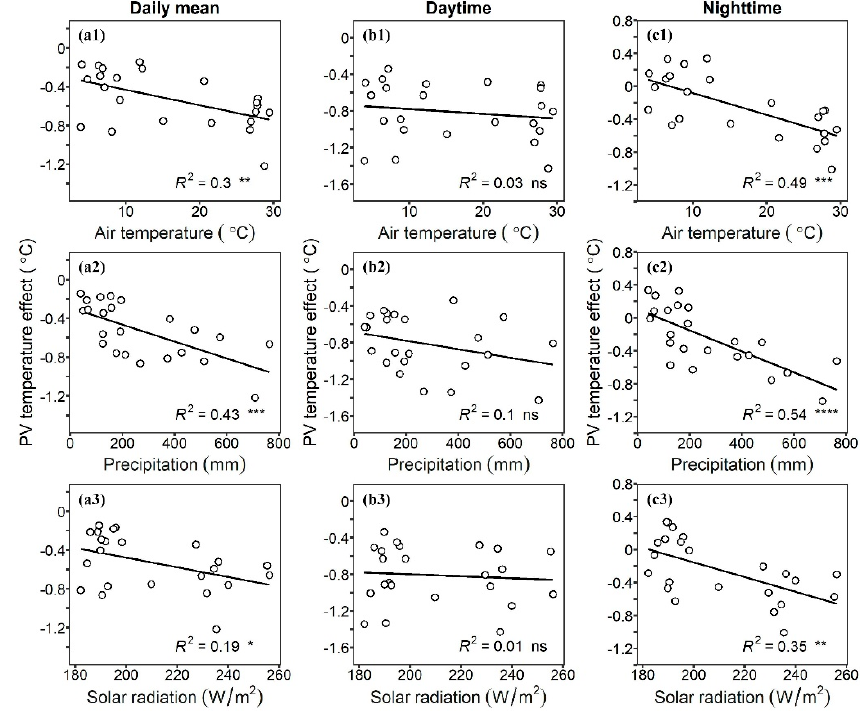
Figure 4. The relationship between annual ( a ) daily mean, ( b ) daytime, and ( c ) nighttime PV temperature effect with ( a1,b1,c1 ) air temperature, ( a2,b2,c2 ) precipitation, and ( a3,b3,c3 ) solar radiation across the 23 PV powerplants.. The solid lines are the linear regression lines; ns, *, **, *** and ****: statistically significant at p > 0.05, p < 0.05, p < 0.01, p < 0.001, and p < 0.0001 levels.